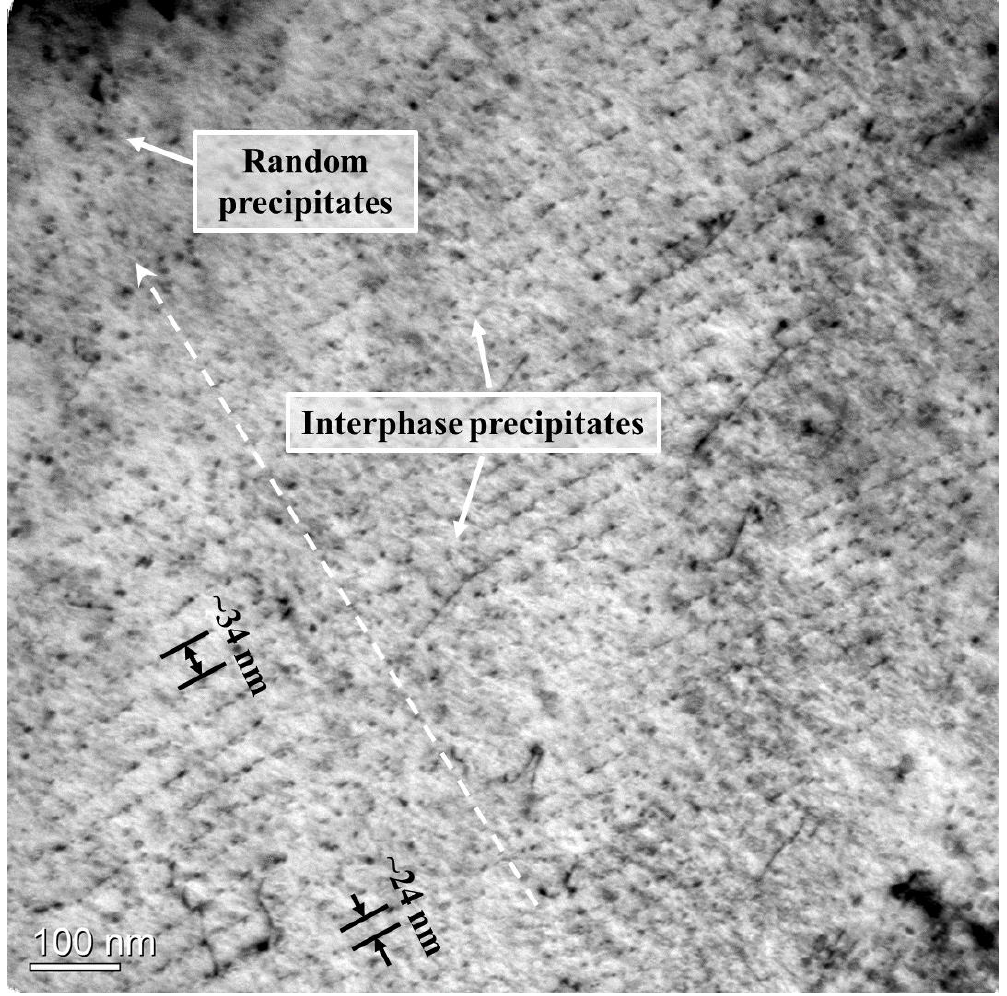
Figure 4. Bright-field TEM image obtained by FEI Tecnai F20 FE-TEM showing nanometer-sized precipitates in the hot-rolled sample.